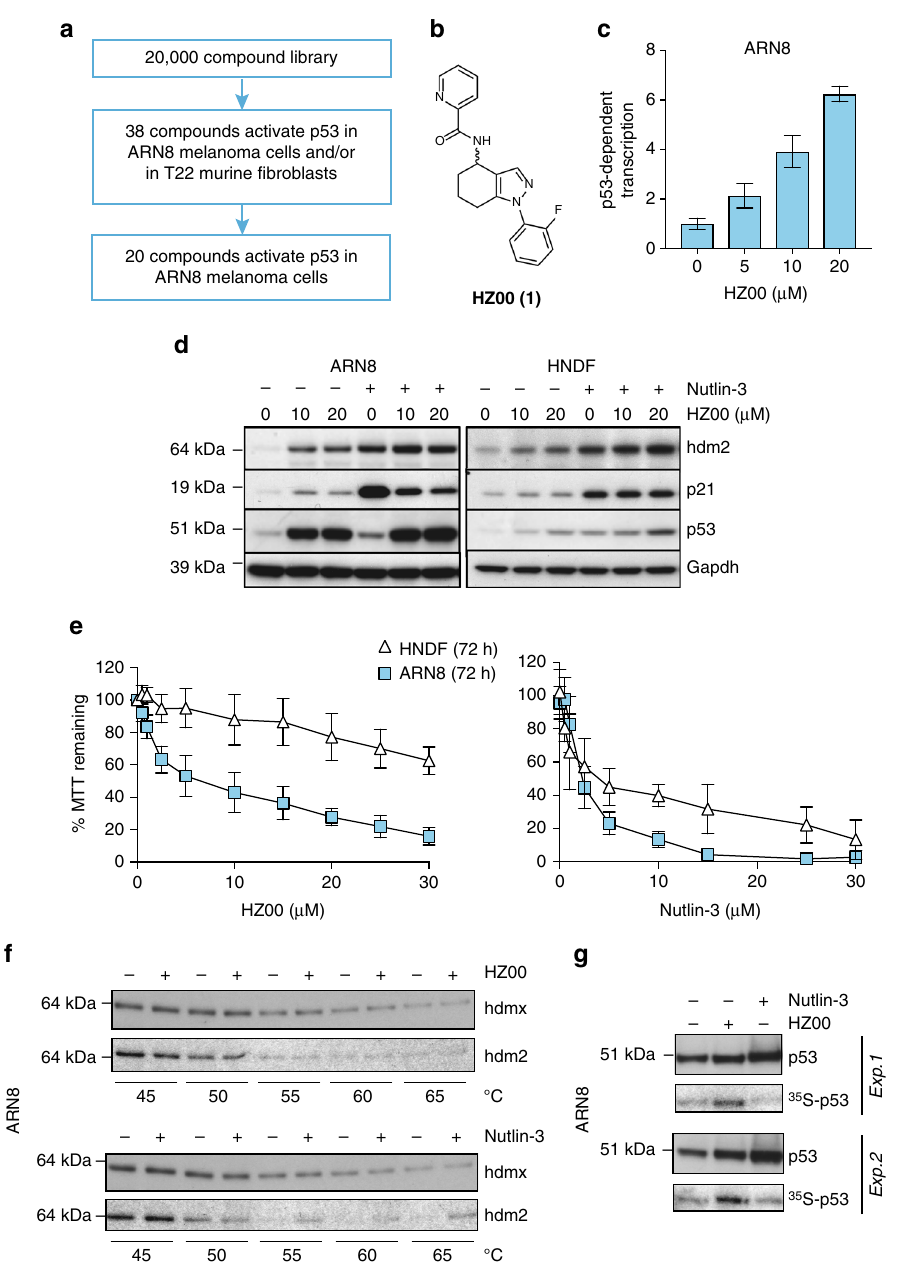
Fig. 1 Discovery and activity of HZ00. a Compound library screening strategy to identify 20 compounds capable of activating p53 transcriptional function in ARN8 melanoma cells >1.5-fold and did not activate or did so below 1.5-fold in T22 fi broblasts. b The structure of HZ00 ( 1 ). c p53 wild-type ARN8 human melanoma cells were treated for 16h with HZ00 and the level of p53-dependent transcription measured by CPRG assay. Values correspond to the average of three technical repeats±SD and are representative of 5 biological replicates. d ARN8 or HNDF were treated with HZ00 for 1 h and then 2 µ M nutlin-3 was added for an additional 18h. Levels of p53, as well as downstream targets hdm2 (human mdm2) and p21 were determined. Levels of gapdh were used to monitor protein loading. e ARN8 or HNDF cells were treated with the indicated compound concentrations for 72h and subjected to MTT assays. Values correspond to the average of 4 (HZ00) or 3 (nutlin-3) biological replicates ± SD. f ARN8 soluble cell extracts were prepared for the cellular thermal shift assay (CETSA) in PBS as described 37 and subjected to increasing temperatures in the absence or presence of 100 μ M HZ00 or nutlin-3. Samples were centrifuged and hdm2 or hdmx were detected in the supernatants. g ARN8 cells were treated with 20 μ M HZ00, 5 μ M nutlin-3 or vehicle (DMSO) for 5h 50min and pulse labeled with 35 S-Met-Cys for 30 min (6h 20min total). p53 was immunoprecipitated and p53 protein levels were determined by